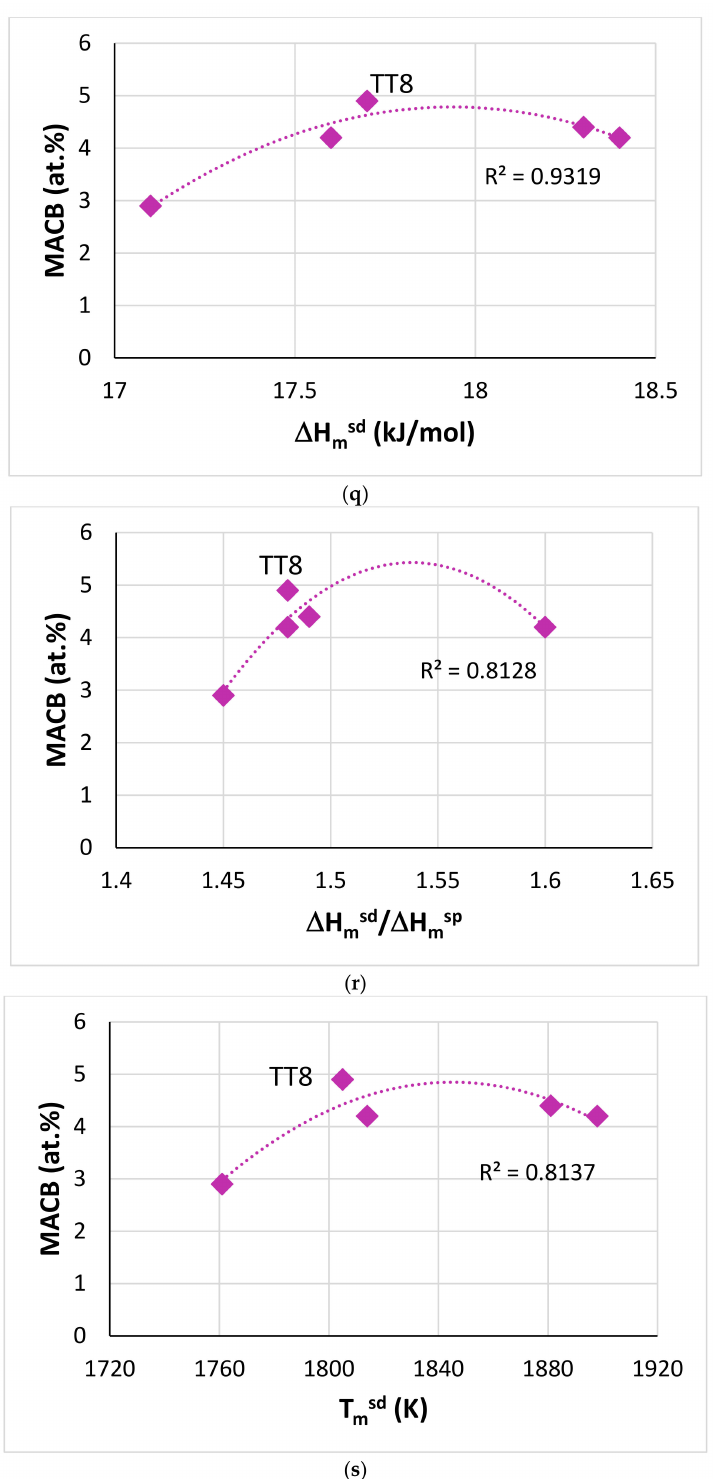
Figure 3. MACSi ( a , c , e , g , i , k , m , o ), MACTi ( b , d , f , h , j , l , n , p ) and MACB ( q , r , s ) versus parameters for alloys TT1, TT2, TT3, TT4 and TT8, and their basis/reference alloys KZ3, KZ4, KZ5, KZ7 and JG3. Diamonds for B containing alloys. Colours ( a – p ), brown TT1, KZ3, green TT2, KZ4, red TT3, KZ7, purple TT4, KZ5, blue TT8, JG3. Pink for the MACB data. The alloy TT8 is indicated in ( q ) to ( s ). If TT8 were to be excluded, the R 2 values for the parabolic fit of the data change to 0.9986, 0.813 and 1, respectively in ( q , r , s